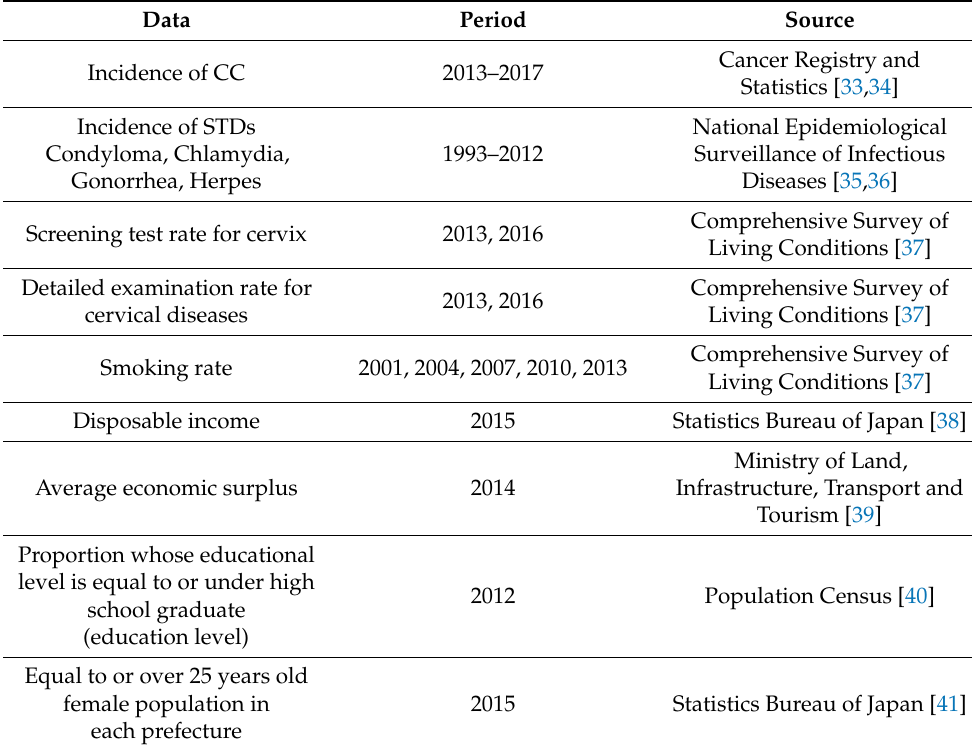
Table 1. Variables used in analysis with their source and